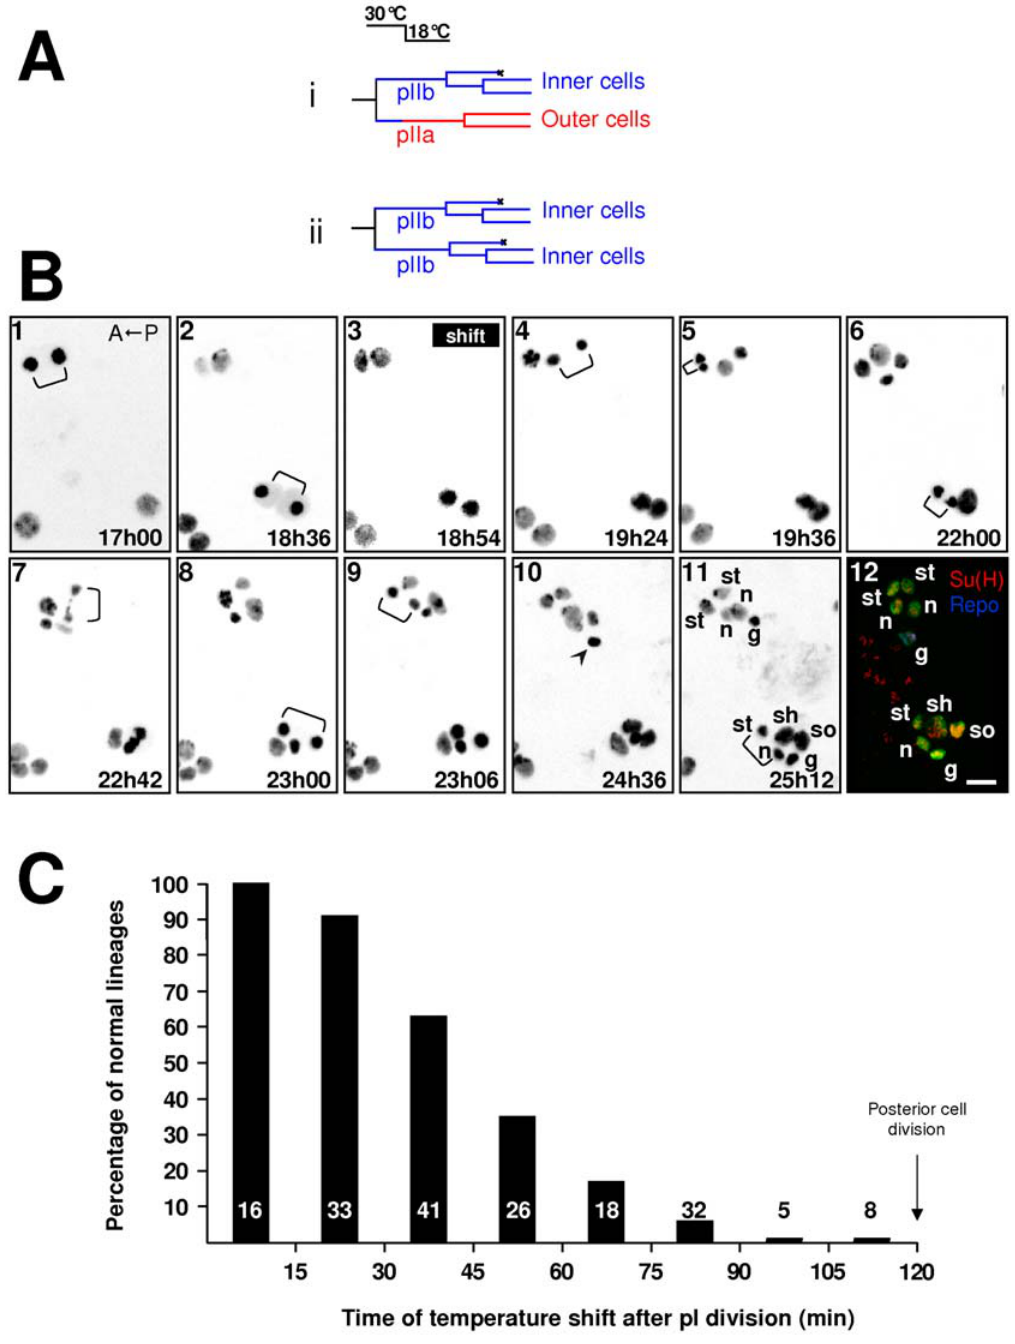
Figure 2. Cells are more receptive to endogenous N-pathway activation during their first hour of life. The acquisition of a pIIa identity was used as an index of Notch pathway activation in the posterior secondary precursor cell. A N ts /Y; neu . H2B::YFP pupae imaged in vivo was temperature shifted from 30 u C to 18 u C at a given moment after pI division enabling the N-receptor to be endogenously activated. A) Lineages expected if the posterior secondary precursor cell responded or not to Notch activation (i and ii respectively). (B) Representative frames from an in vivo recording followed by immunostaining of two microchaete lineages. Anterior is on the left. The temperature shift was applied at 18h54 after pupal formation (APF). Brackets indicate cell divisions. Time APF is shown at the bottom right of each frame. At 18 u C, development proceeds half as quickly as at 25 u C. The arrowhead (frame 10) indicates apoptosis of the glial cell. In frame 12, bristle lineage cells are revealed by anti-GFP antibody (green). Su(H) and Repo immunoreactivities were used to identify socket (so) and glial (g) cells respectively (yellow and blue). The other cell identities have been ascribed based on the characteristics of their divisions recorded in vivo , n: neuron, st: sheath, sh: shaft cell. Each image results from the merge of 5 horizontal optical sections. Note that when the temperature shift was applied 1h54 after the pI division (upper cluster), the resulting organ was formed exclusively by inner cells. In contrast, when applied 0h18 after the pI division (lower cluster), a normal organ resulted. Scale bar: 5 m m. (C) Percentage of normal sensory organs observed when the temperature shift was applied at different moments after pI division (abscissa). Note that normal sensory organs were observed when the temperature shift was applied during the first 45 min of the secondary precursor cells life. In this and other histograms, the numbers at the base of the bars indicate the number of sensory clusters analyzed.